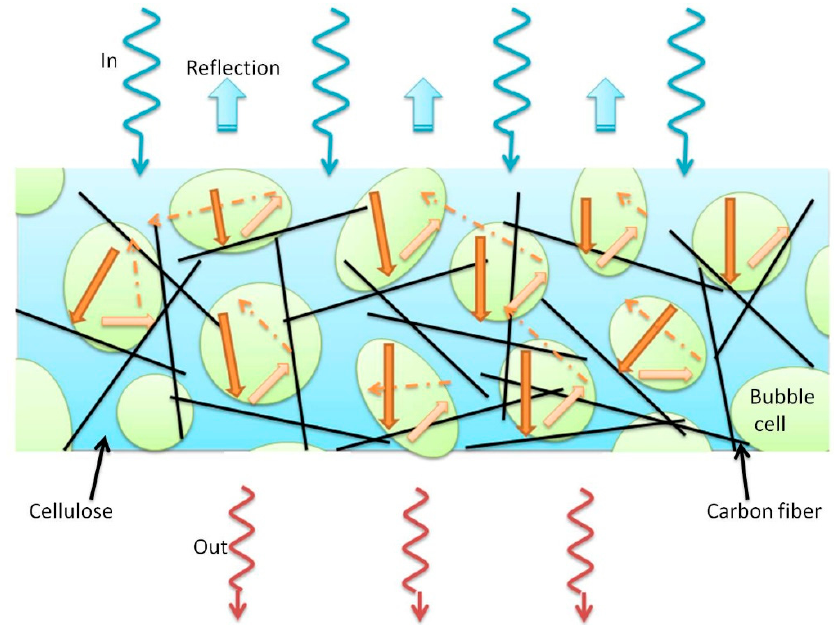
Figure 6. Schematic description of the microwave transfer across cellulose/carbon fiber composite foam.